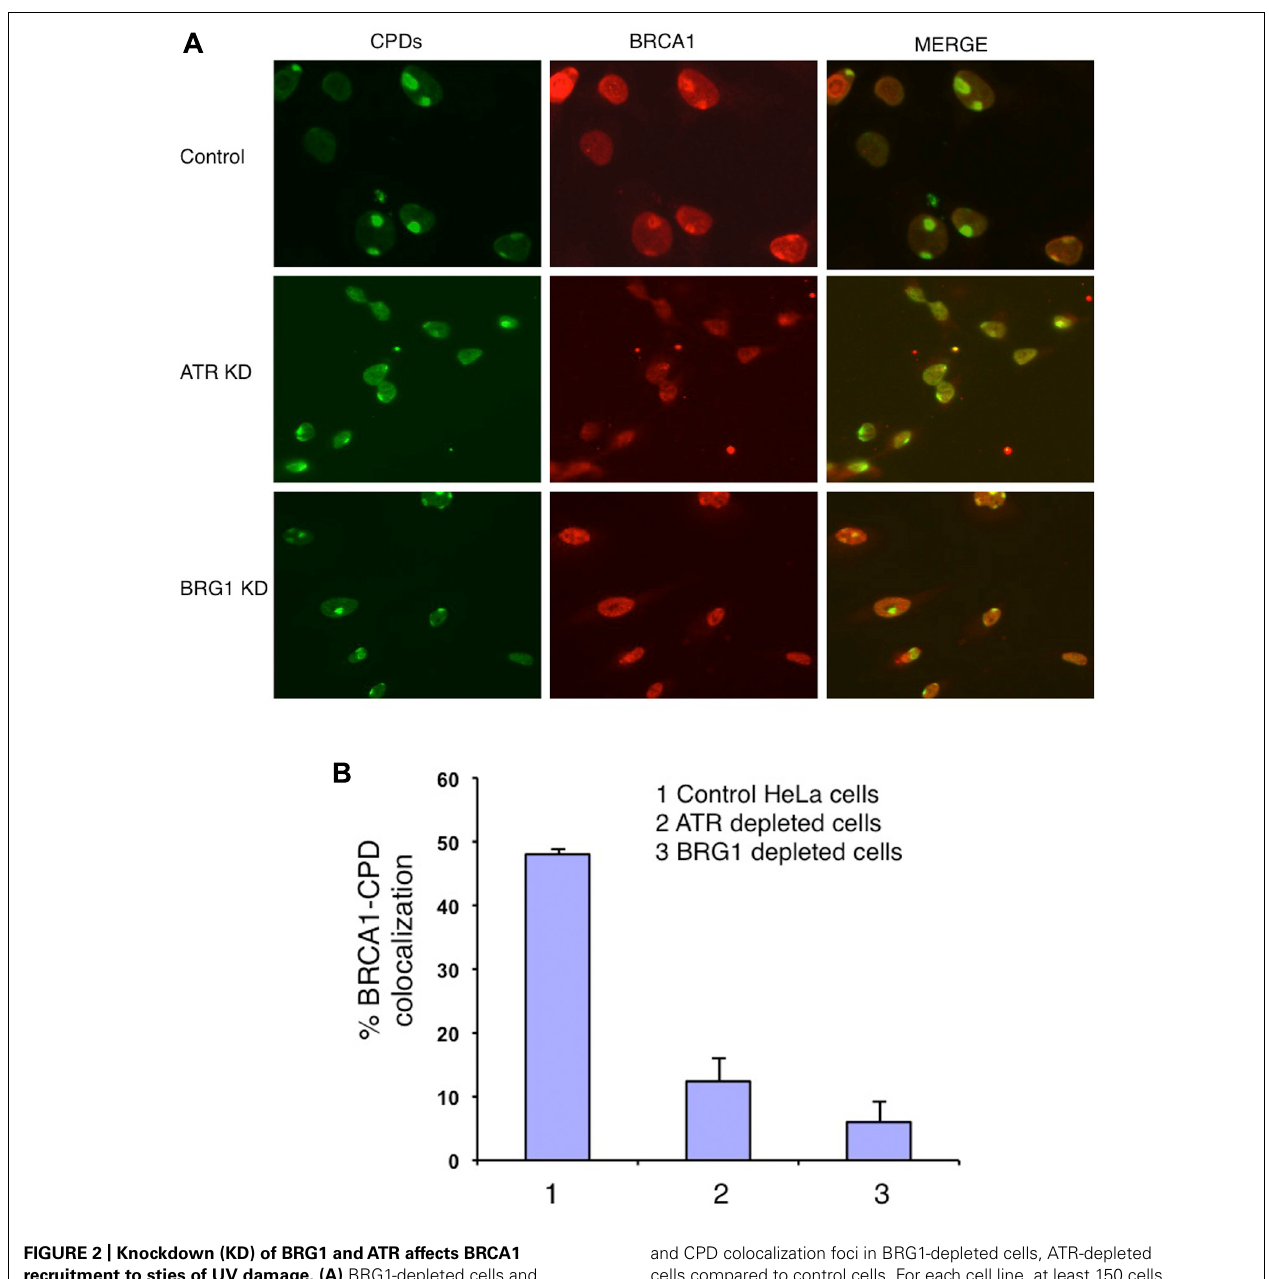
FIGURE 2 | Knockdown (KD) of BRG1 andATR affects BRCA1 recruitment to sties of UV damage. (A) BRG1-depleted cells and ATR-depleted cells showed a decrease in the number of CPD-BRCA1 foci compared to control cells 30 min post-irradiation. Experiments were performed as described in Figure 1A. (B) Quantitation of BRCA1